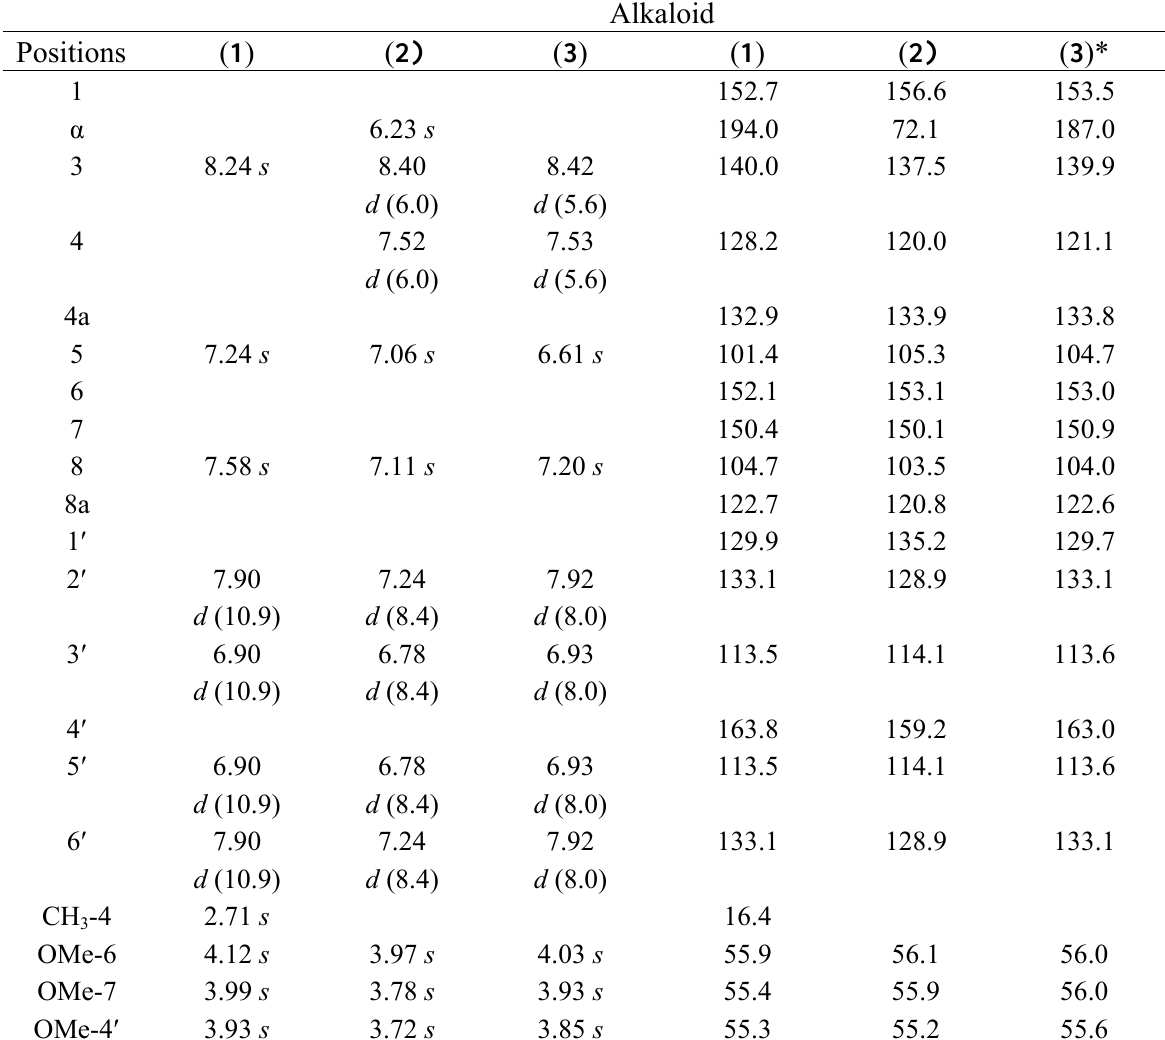
Table 1. 1 H-NMR (400 MHz) and 13 C-NMR (100 MHz) spectral data of compounds 1 , 2 ( δ in ppm, J in Hz). and 3 in CDCl 3